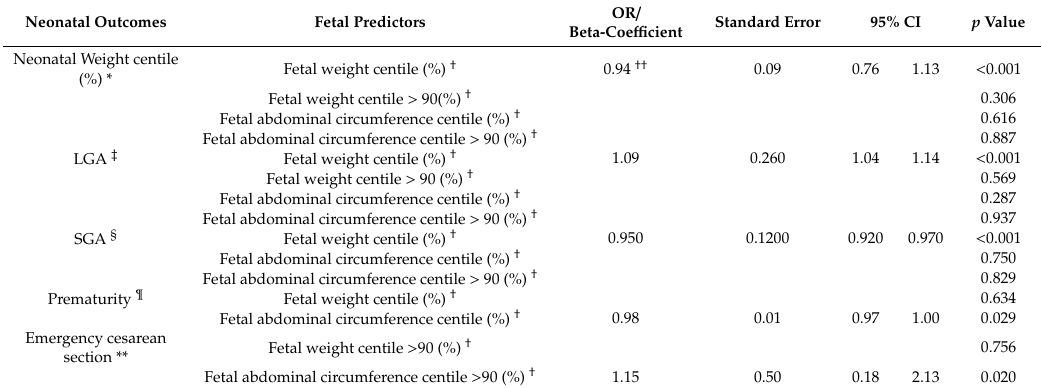
Table 3. Main fetal predictors of adverse neonatal and maternal